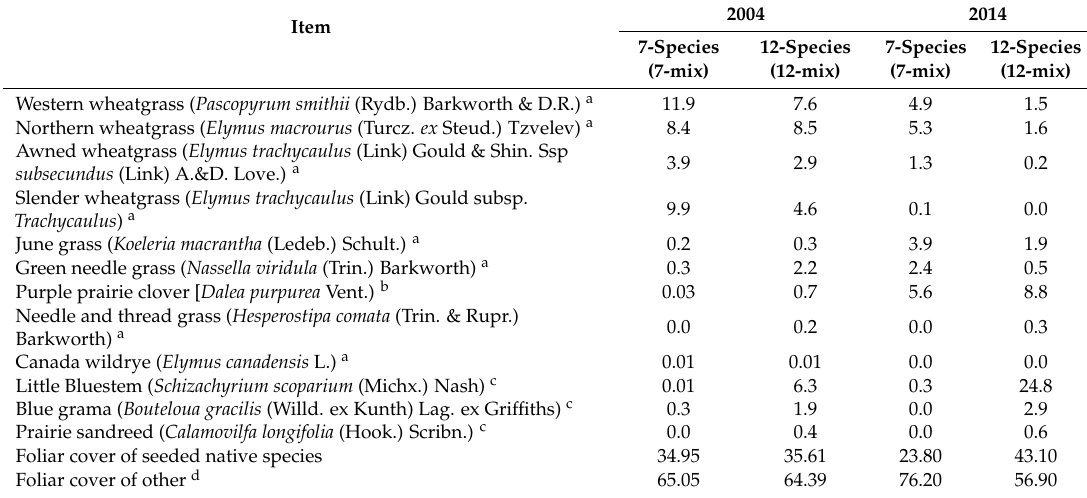
Figure A2. Pasture NDF content (%DM) for the seed mixture (7-mix, 12-mix) × grazing system (CG = continuous grazing, DRG = deferred rotational) × year interaction ( p < 0.05). Significance difference among treatment within a year was indicated by lower case letters ( a , b , c and ns = not significant) and standard error of means was indicated by error bars. Table A1. Foliar cover (%) of seeded native and other species for the 7- and 12-mix pasture in 2004 and 2014.